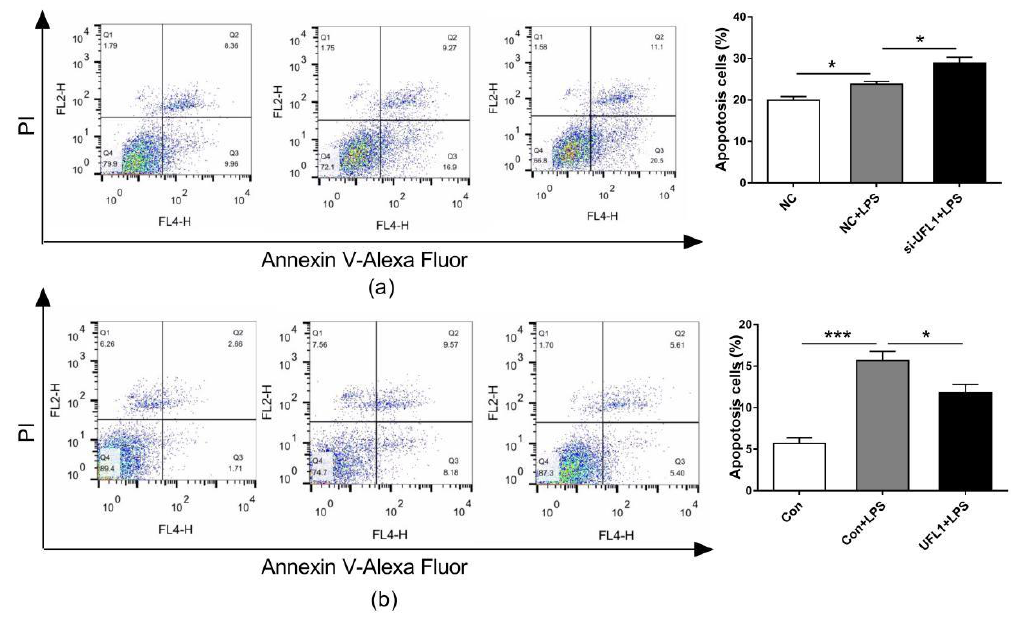
Figure 4. UFL1 protects the bGCs against LPS-induced apoptosis. ( a ) Effect of Ufl1 siRNA on apoptosis in LPS-challenged bGCs. ( b ) Effect of Ufl1 overexpression on apoptosis in LPS-challenged bGCs. ∗ p < 0.05; ∗∗ p < 0.01; ∗∗∗ p <